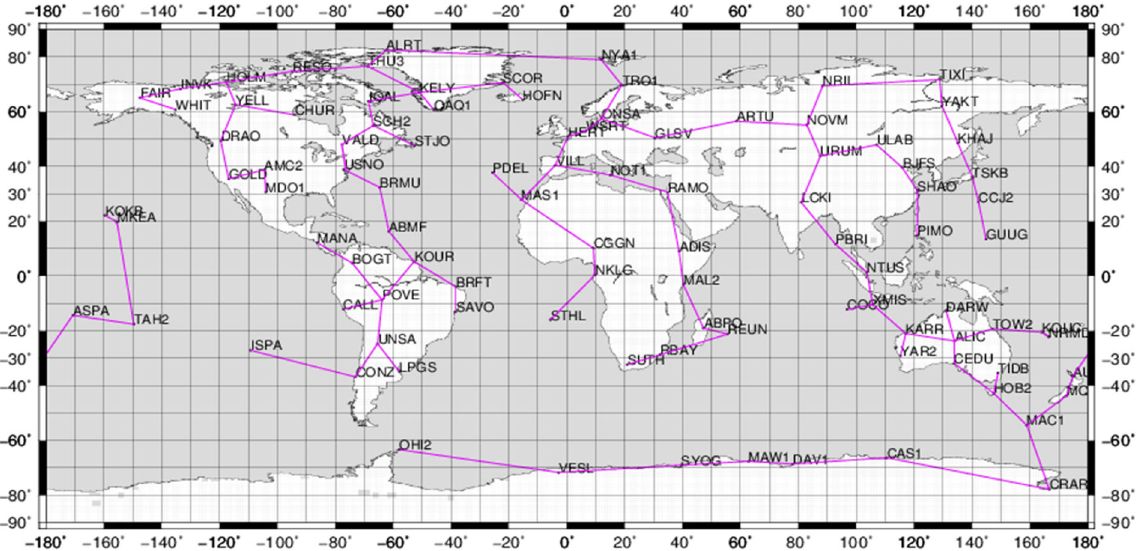
Figure 5. Independent baseline network diagram of about 100 stations generated using OBS ‐ DEN.